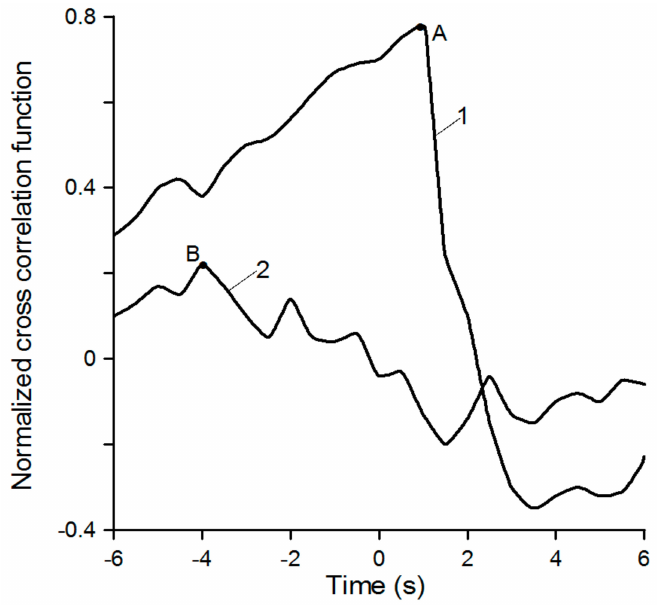
Figure 12. Cross correlation functions of plowing depth oscillations from the influence of the surface’s longitudinal profile and plough draft resistance.